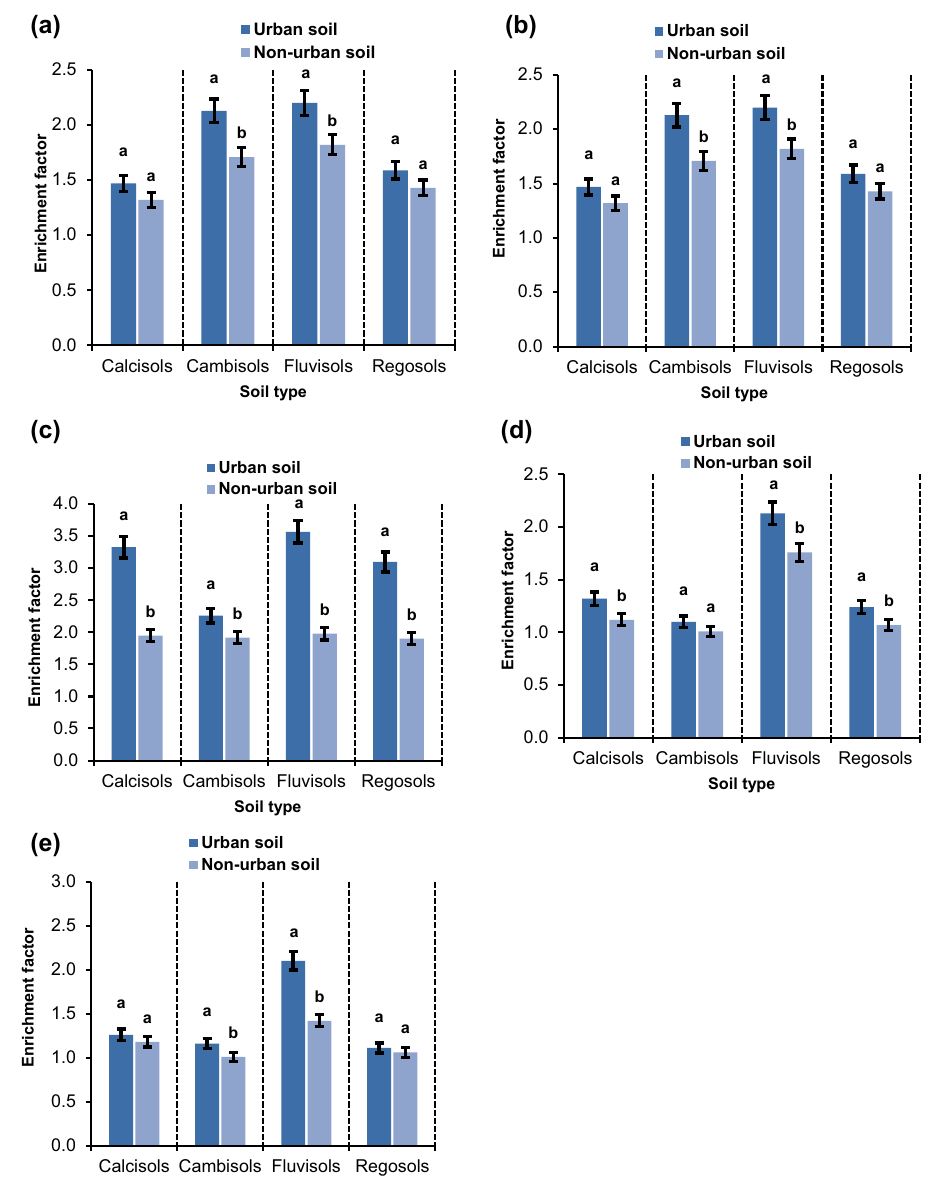
Figure 3. The comparison of the mean enrichment factor of Zn ( a ), Cu ( b ), Cd ( c ), Pb ( d ), and Ni ( e ) between urban and non-urban soils in different soil types. Different letters indicate significant differences in enrichment factor within each soil type at P < 0.05 confidence